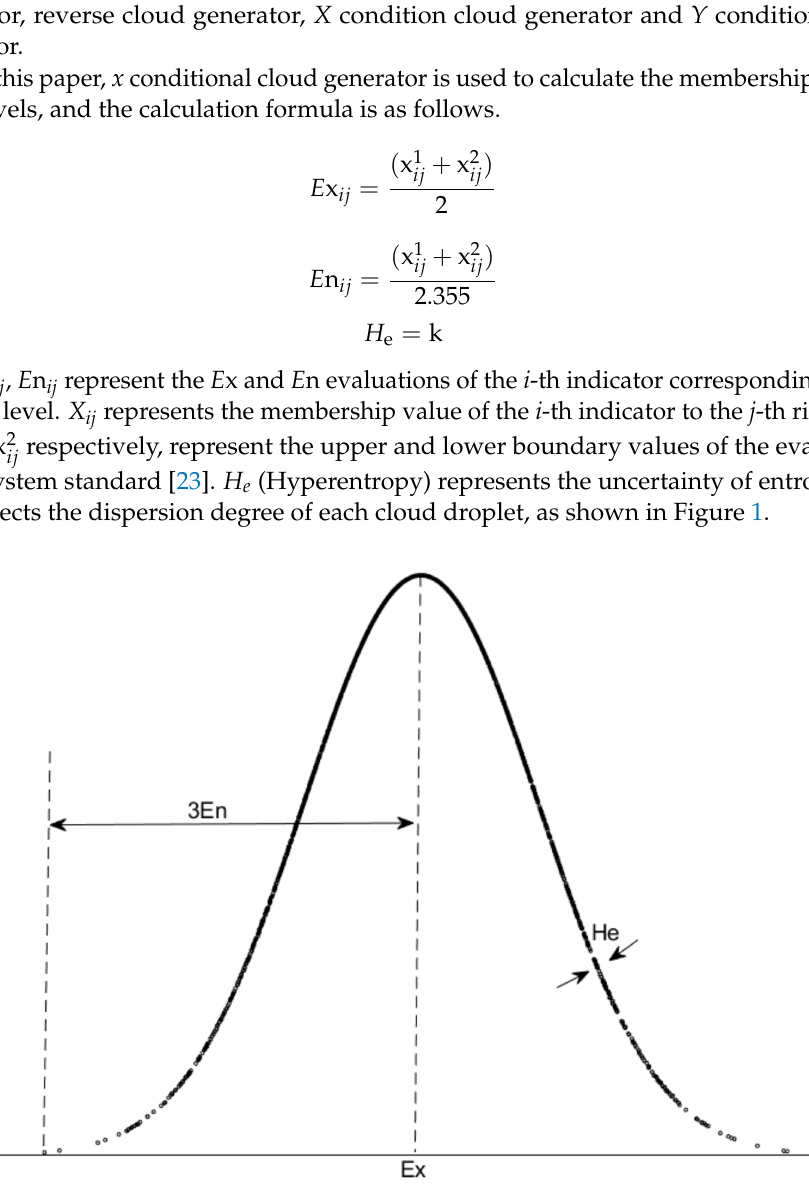
Figure 1. Cloud model characteristic